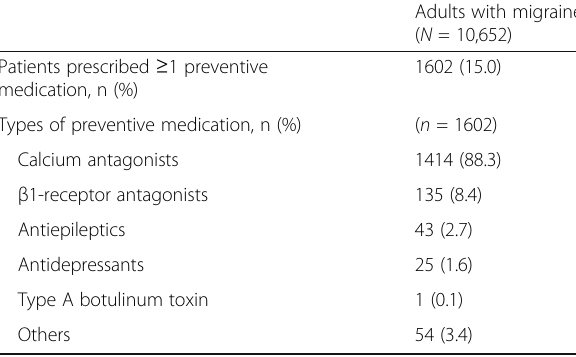
Table 3 Preventive medication prescribed for